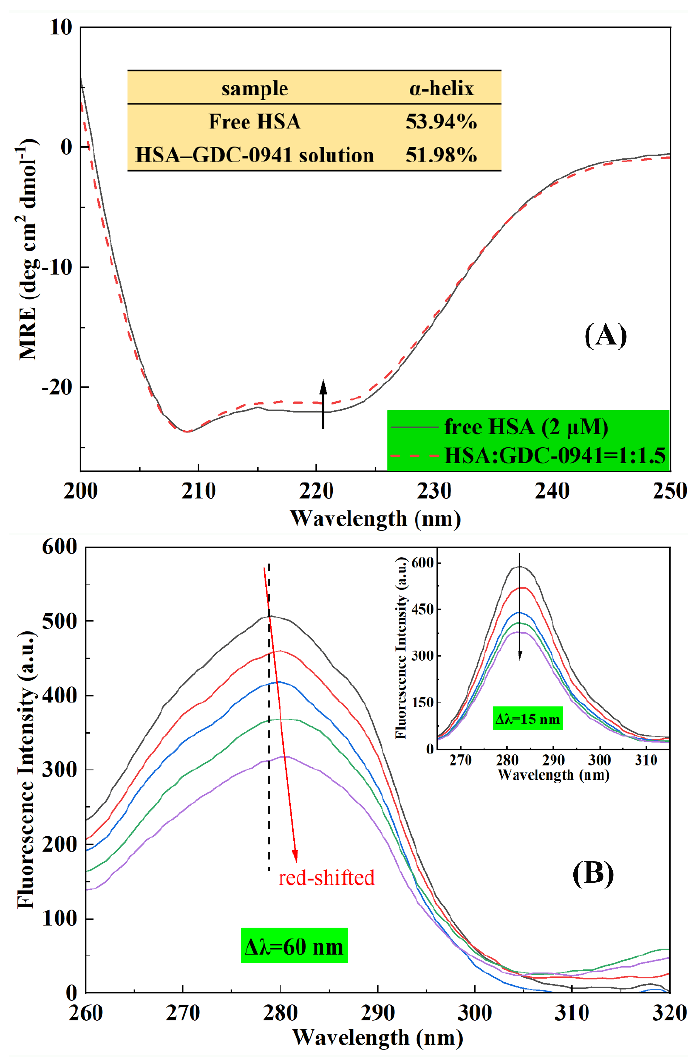
Figure 8. ( A ) CD spectra of HSA in the absence and presence of GDC-0941. Conditions: C HSA = 2 µ M; C GDC-0941 = 0, 3 µ M; pH = 7.4; T = room temperature. ( B ) The synchronous fluorescence spectra of HSA in the absence and presence of GDC-0941 for ∆ λ = 60 nm. The inset represents ∆ λ = 15 nm. Conditions: C HSA = 2 µ M; C GDC-0941 = 0, 1.5, 3, 6, 9 µ M; pH = 7.4; T = room temperature.